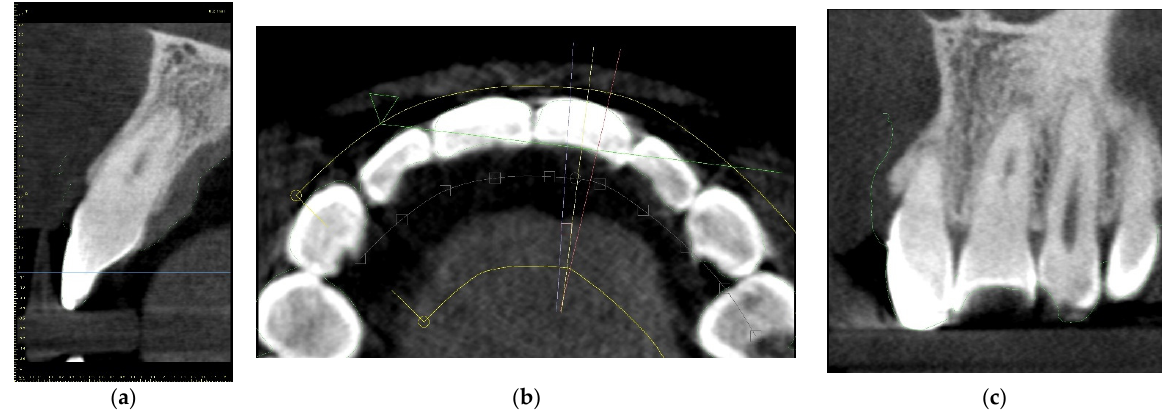
Figure 9. Figure showing CBCT data and intraoral scan (green line) alignment from different views: